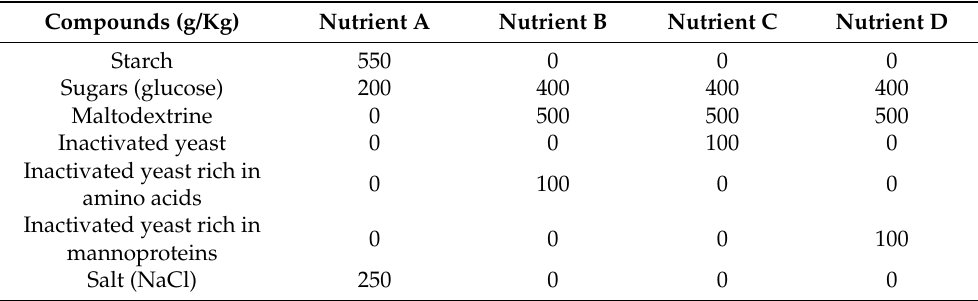
Figure 1. Experimental design for green table olive manufacturing. Abbreviation: °Bé, Baumè degree; NdB-1 and NdB-2 codes refer to the control trials; NdB-3, NdB-4, NdB-5, and NdB-6 codes refer to the experimental trials; L. , Lactiplantibacillus . Table 1. Chemical composition of the four nutrients used in the production of ‘Nocellara del Belice’ Seville-style table olives.